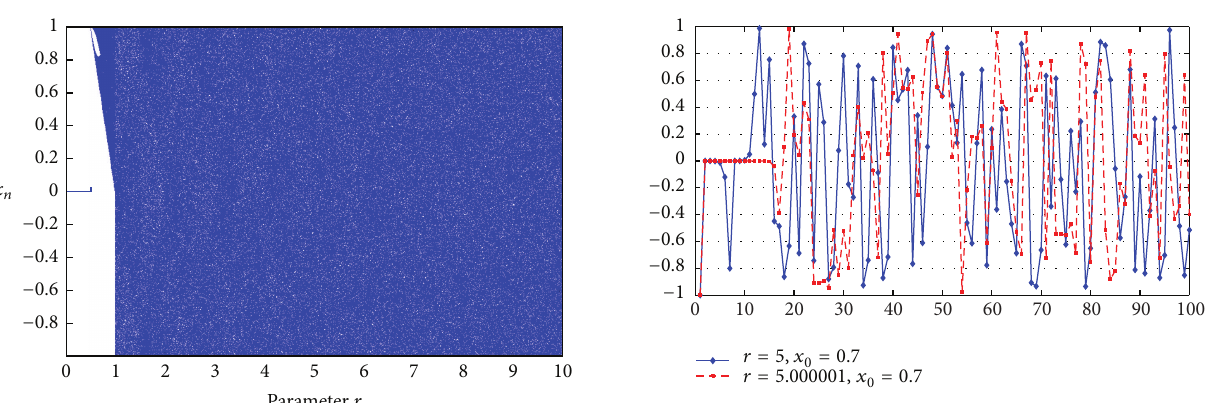
Figure 1: The bifurcation diagram of the 𝑓 𝑟 map for 𝑟 ∈ [0, 10] .